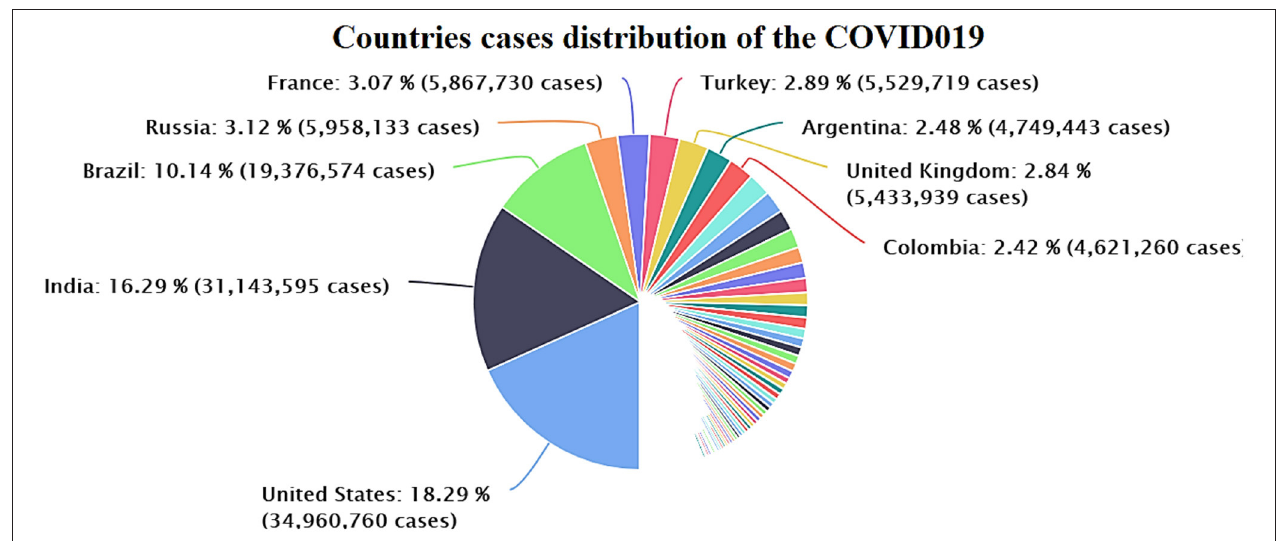
FIGURE 6 | Distribution of the cases in various countries worldwide (July 18, 2021). Source: Data provided by World Health Organization related to the coronavirus